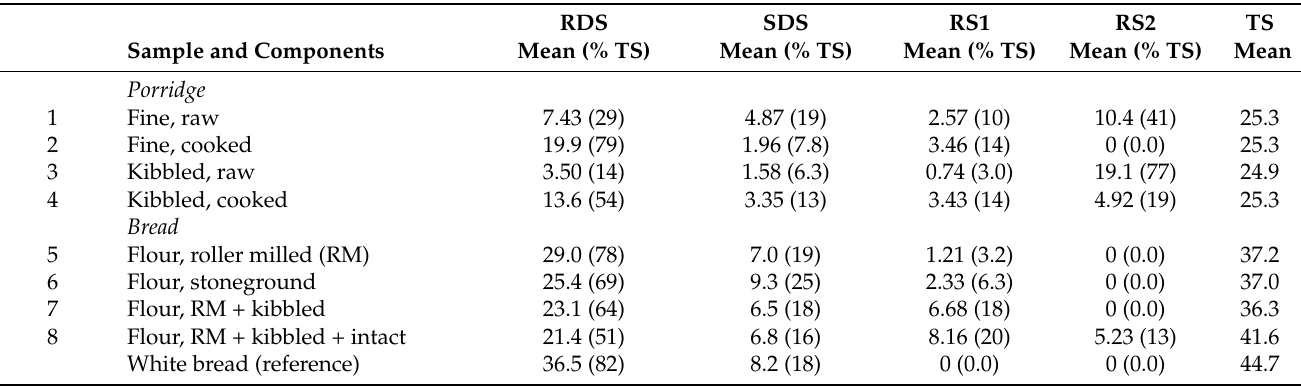
Table 2. Content of starch fractions in wholegrain wheat products (g/100 g sample) 1 and percent contribution to total starch (TS) in each sample